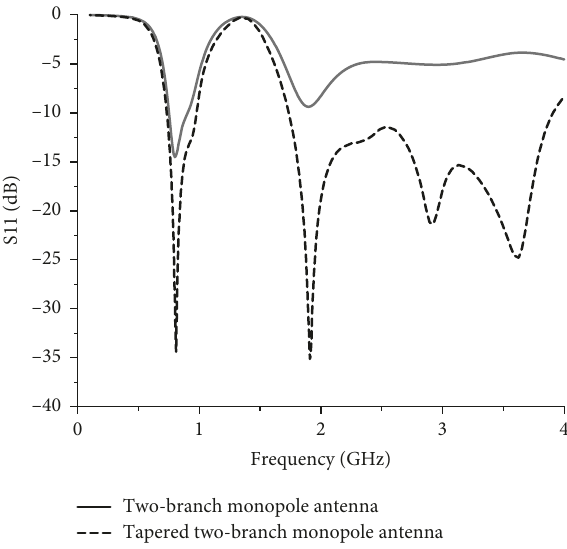
Figure 4: Comparison of two-branch monopole antenna and tapered two-branch monopole